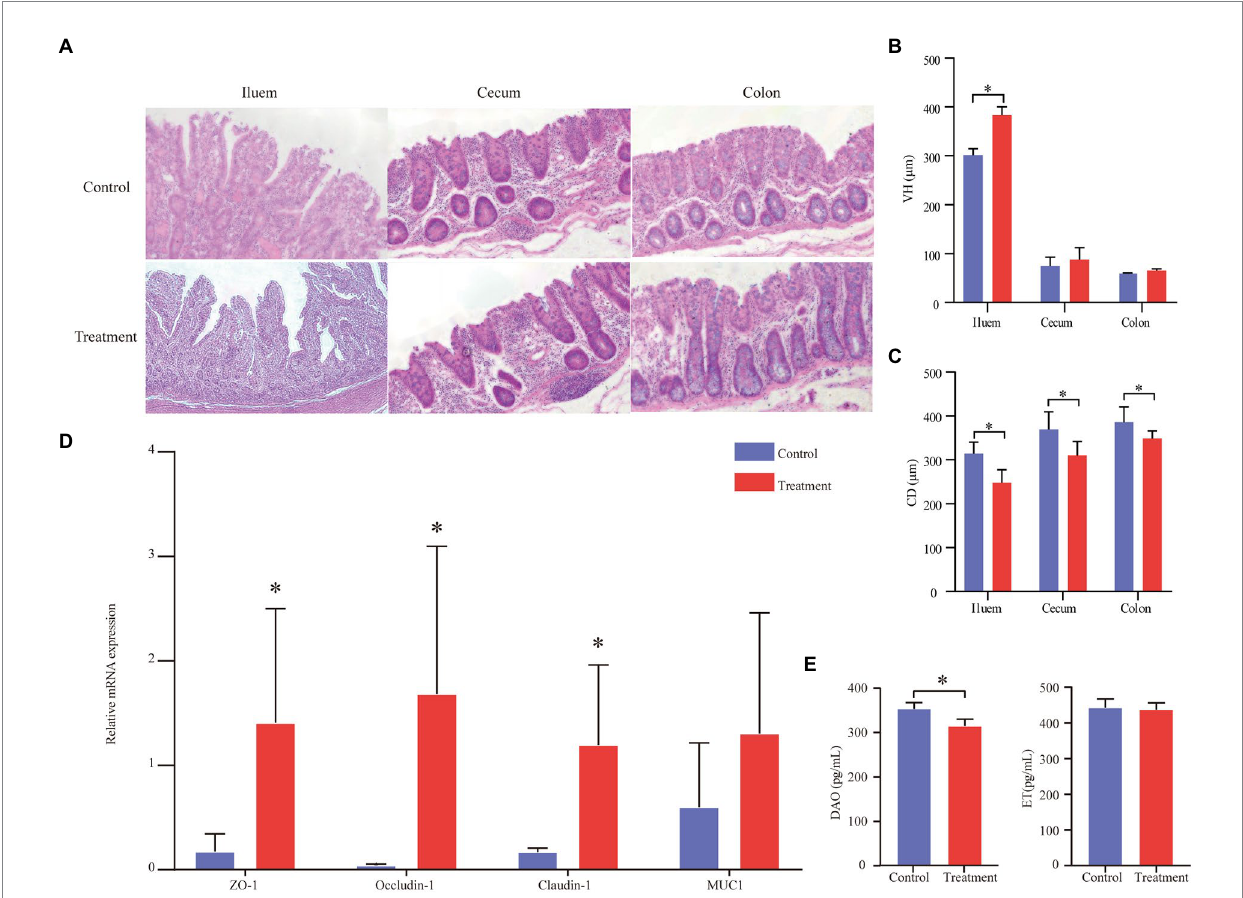
FIGURE 3 Effect of grape pomace diet on the expression of tight junction proteins of finishing pigs. (A) Effects of grape pomace dietary on the intestinal morphology of finishing pigs. (B) VH of ileum, cecum, and colon ( n = 6). (C) CD of ileum, cecum, and colon ( n = 6). (D) The mRNA expression of ZO-1, Occludin-1, Claudin-1, and MUC1 was quantitated by real-time PCR ( n = 6). Control group, a basal diet; treatment group, a basal diet’s wheat bran is replaced with grape pomace. Data were shown as means ± SD, * refers to significant difference ( p < 0.05). VH, villous height; CD, crypt depth; DAO, diamine oxidase; ET, endothelin; ZO-1, zonula occludens 1; and MUC1, Mucin 1; (E) Serum DAO and ET content ( n =